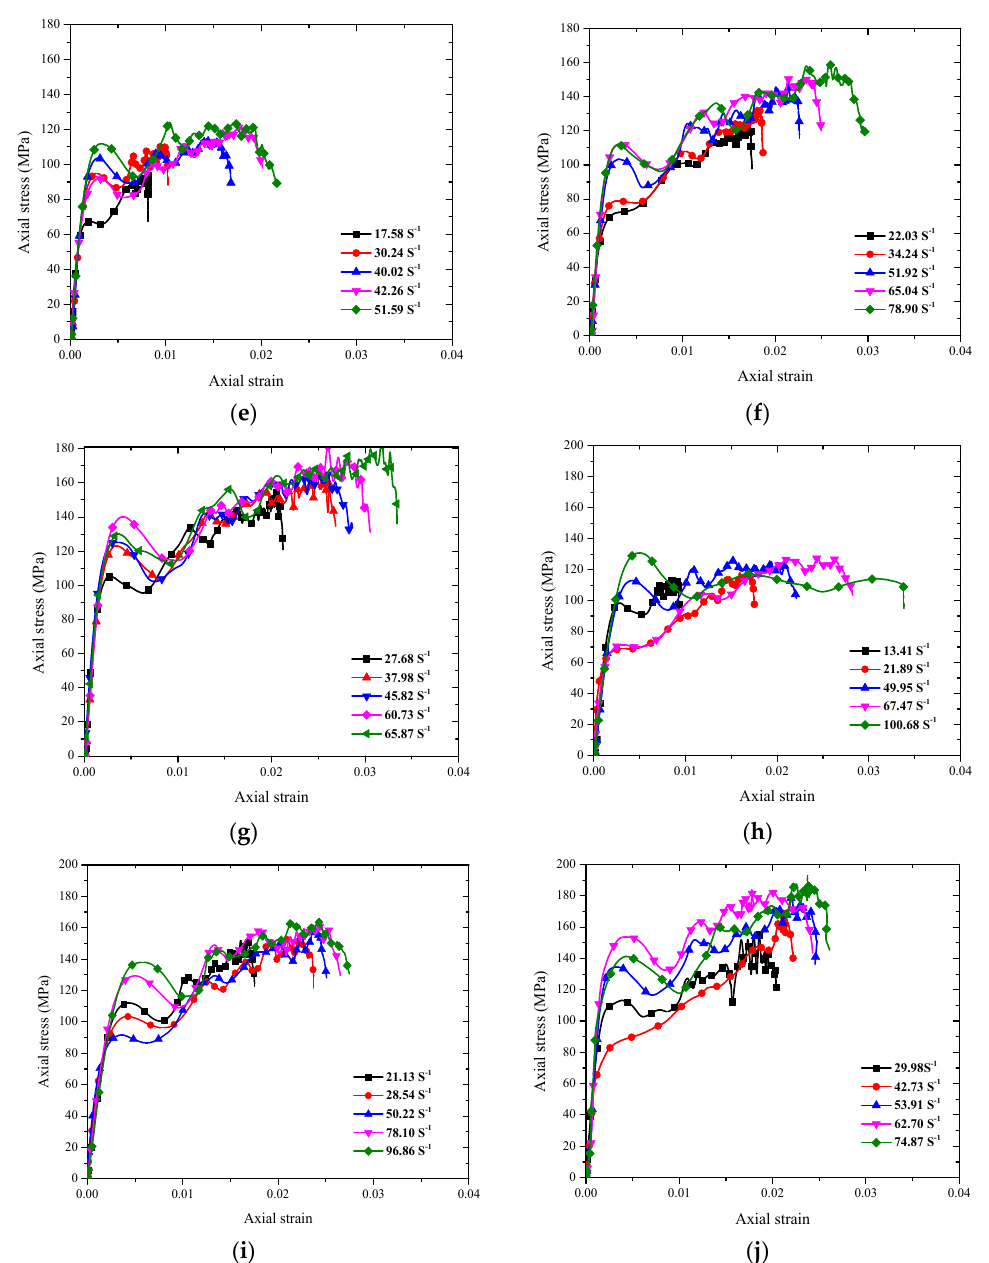
Figure 9. Stress–Strain curves of FCHC under dynamic compression. ( a ) Unconfined specimens; ( b ) One-layer BFRP-confined specimens; ( c ) Two-layer BFRP-confined specimens ( d ) Three-layer BFRP-confined specimens; ( e ) One-layer AFRP-confined specimens; ( f ) Two-layer AFRP-confined specimens; ( g ) Three-layer AFRP-confined specimens; ( h ) One-layer CFRP-confined specimens; ( i ) Two-layer CFRP-confined specimens; and ( j ) Three-layer CFRP-confined